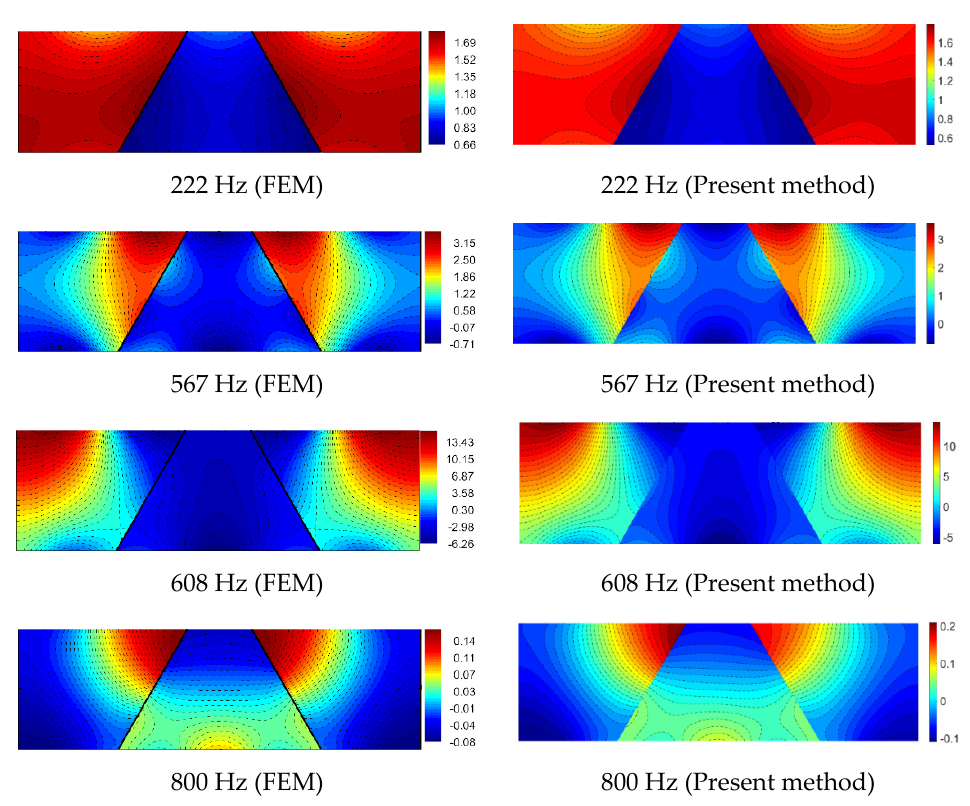
Figure 12. The sound pressure distribution response of the acoustic cavities.